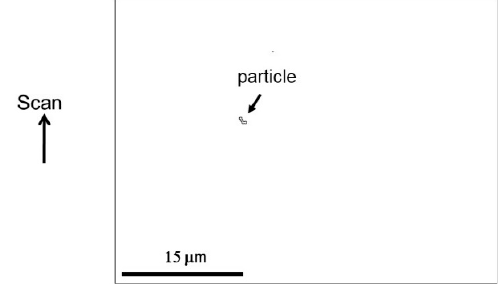
Figure 9. {100} textures of inverse pole figure (IPF) maps for all three directions of ( a ) normal direction (ND), ( b ) scan direction (SD), and ( c ) transverse direction (TD), obtained at a low laser power in the vicinity of the lateral growth threshold. The SiO 2 cap thickness was 123 nm, and the power was 1.4 W. The scan velocity was 15 mm/s. After Sasaki et al. [44].